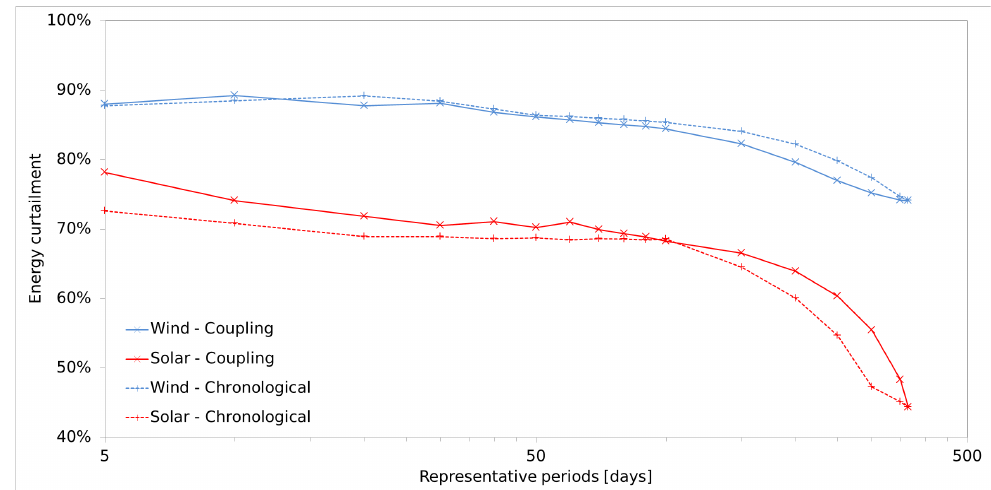
Figure 8. Curtailment of wind and solar energy for the coupling and chronological clustering using different representative